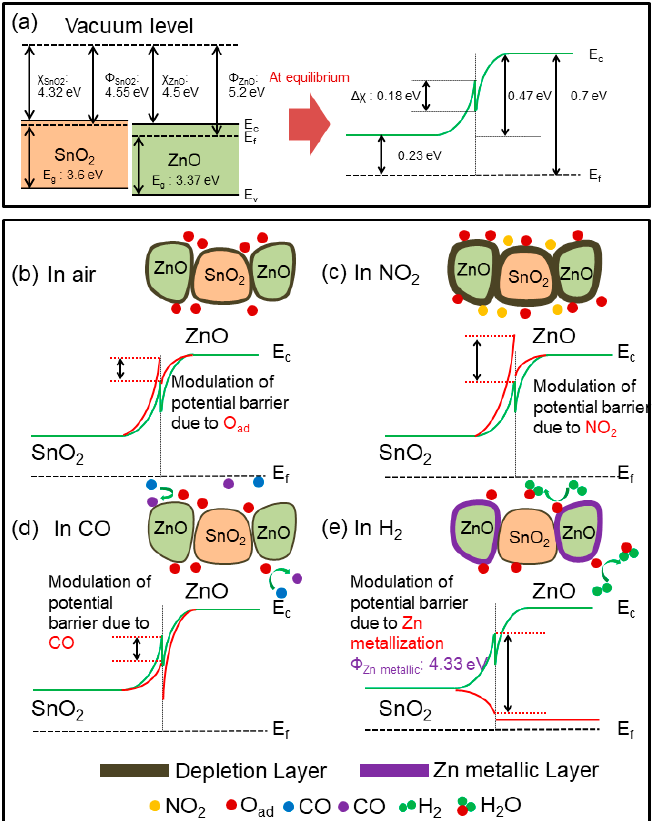
Figure 11. Schematics of sensing mechanism in the SnO 2 -loaded ZnO NFs gas sensor. ( a ) Energy-level diagram of ZnO-SnO 2 in vacuum. The change of potential barriers in ( b ) air, ( c ) NO 2 , ( d ) CO, and ( e ) H 2 .